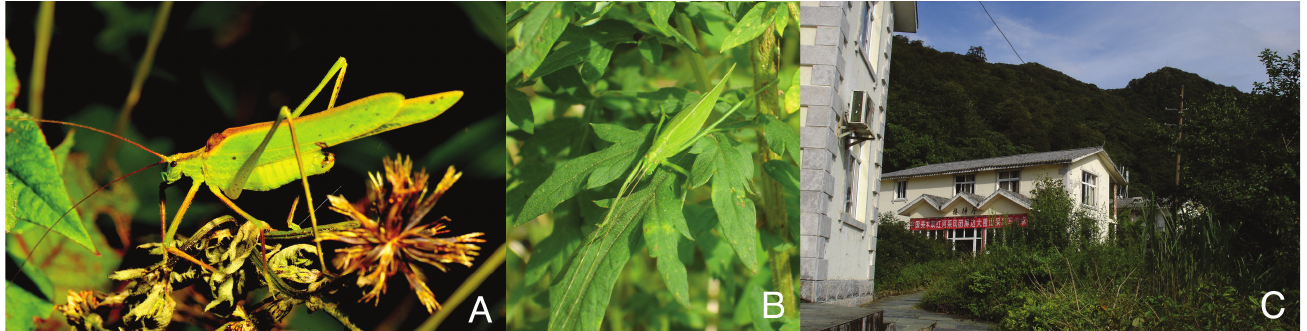
Figure 5. Habitus and habitat of E. diuturna sp. n. A. male (photo by Guoqing Ma), B. female, C. habitat at type locality. The photo of the male is shown under E. fulva in Kang et al.